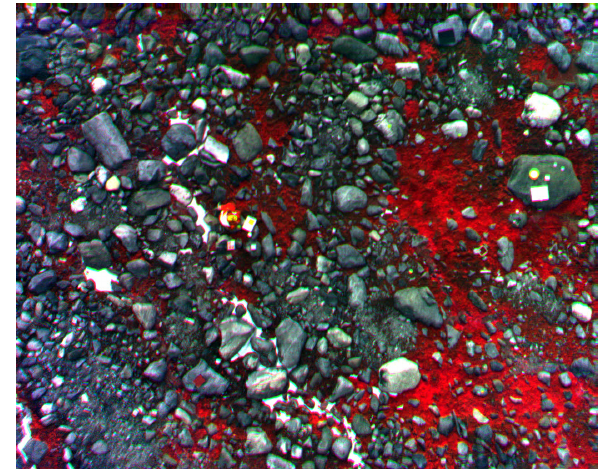
Figure 8: False colour composite (RGB = 800, 670, 550 nm) captured by the mini-MCA.